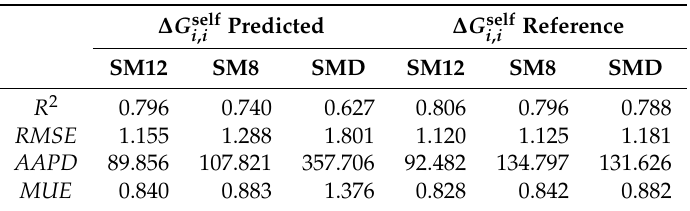
Table 3. A summary of the squared correlation coefficient ( R 2 ), root mean square error ( RMSE ), and mean unsigned error ( MUE ) for ln γ ∞ , and the average absolute percent deviation ( AAPD ) for γ ∞ i , j predicted using the SM12, SM8, and SMD universal solvent model as compared to the reference data from the Minnesota Solvation Database. For the predictions, we compare the case where (1) ∆ G self predicted using the SM12, SM8, and SMD universal solvent model, and where (2) ∆ G self using reference data, as